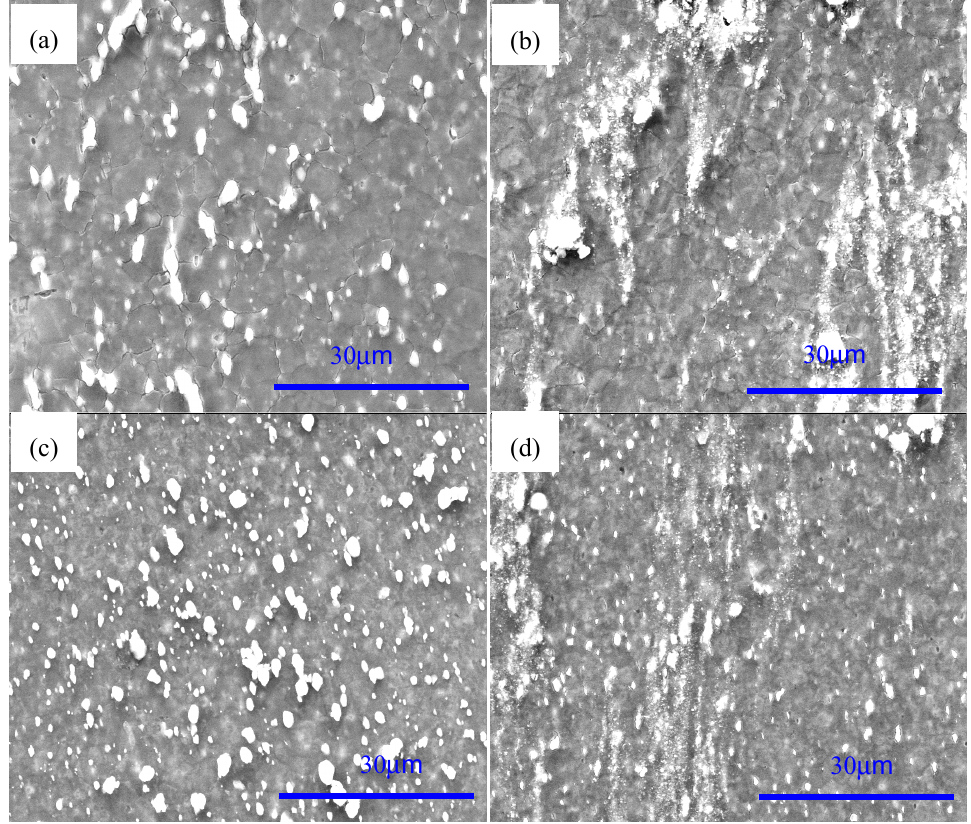
Figure 3. SEM images of AZ91 alloy after multi-pass forging for ( a ) nine passes and ( c ) 12 passes, and nano-SiCp/AZ91 composites for ( b ) nine passes and ( d ) 12